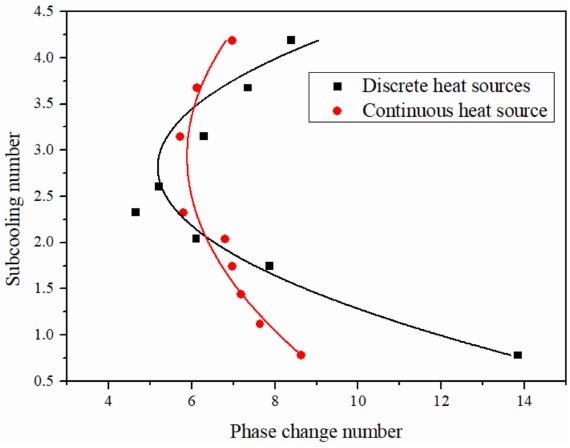
Figure 11. Stability boundary of discrete and continuous heat